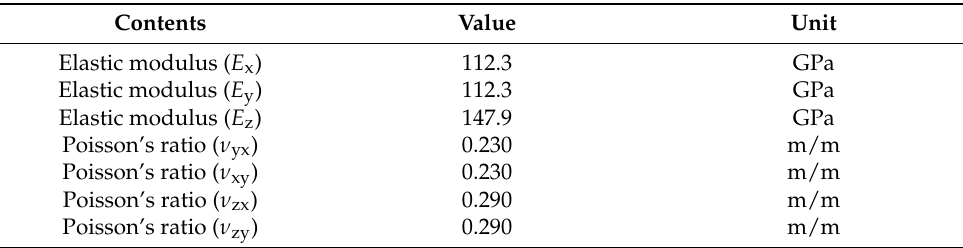
Table 3. Equivalent properties with simulation for circular pores.